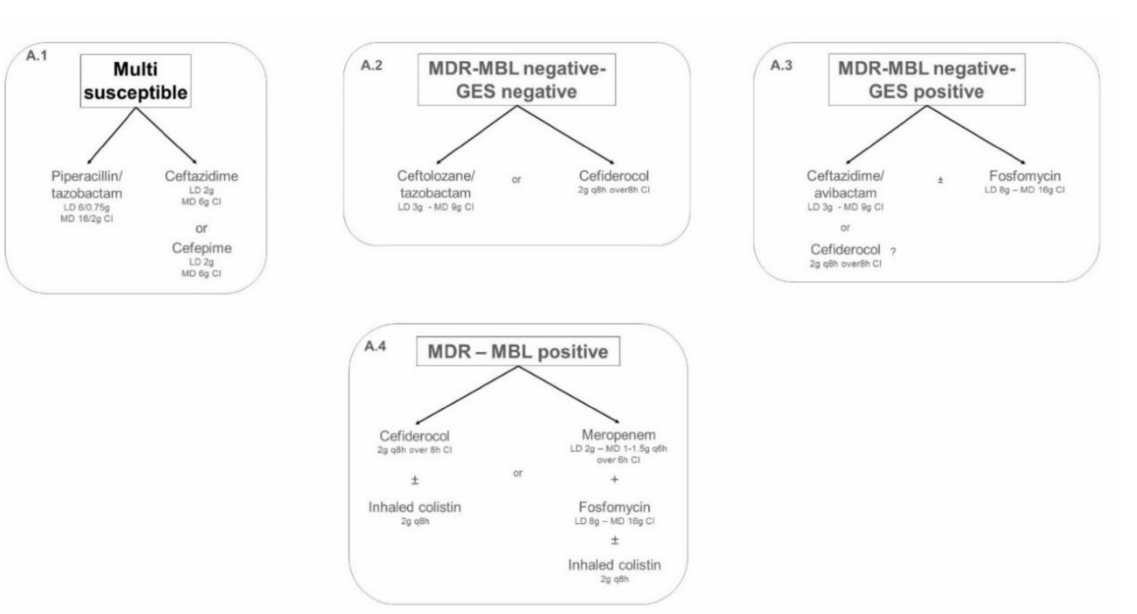
Figure 1. Algorithms for targeted treatment of IVAC caused by Pseudomonas aeruginosa with different pattern of antibiotic susceptibility. CI: continuous infusion; EI: extended infusion; LD: loading dose; MBL: metallo-beta-lactamase; MD: maintenance dose; MDR: multidrug